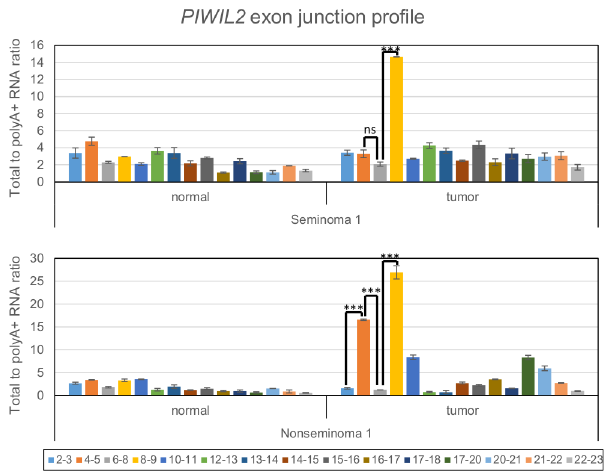
Fig 2. Non-polyadenylated transcription across exon-exon junctions of PIWIL2 gene. qRT-PCR was used to assess the level of total RNA and its polyA+ fraction and the ratio of total RNA to polyA+ fraction was calculated. Seminoma and nonseminoma testicular cancer samples as well as adjacent normal testis tissues were assayed. P-value summary of Mann-Whitney non-paired U test is presented for 4 – 5 and 8 – 9 exon-exon junction peaks (ns – non-significant, *** — p-value <